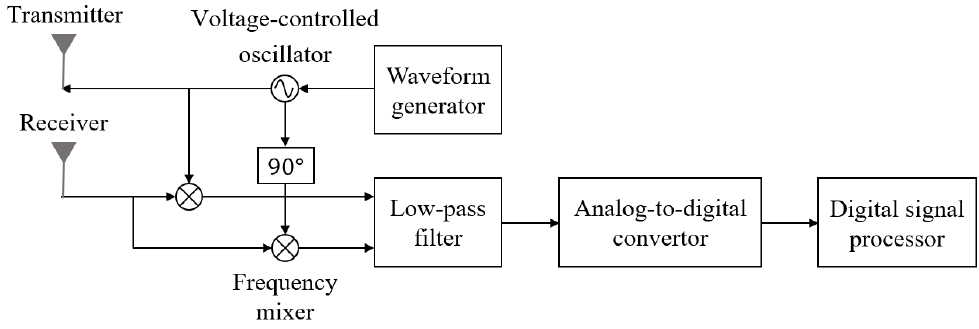
Figure 1. Configuration of the millimeter-wave band FMCW radar system.